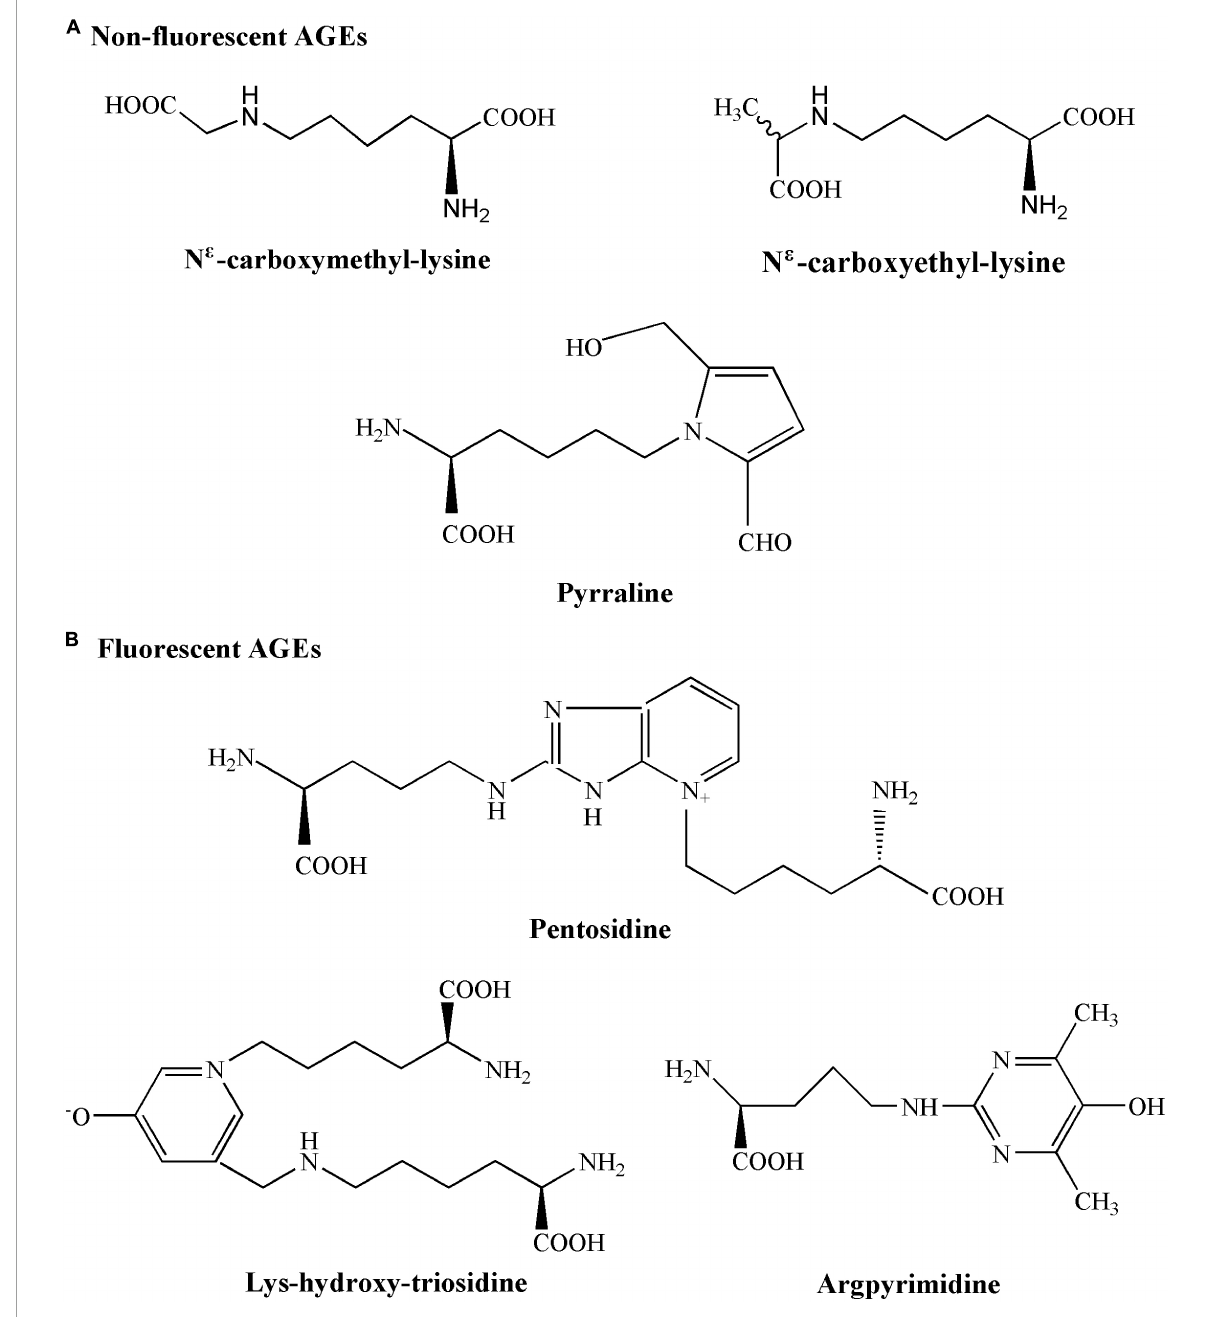
FIGURE2 Chemical structures of non-fluorescent advanced glycation end products (AGEs) and fluorescent